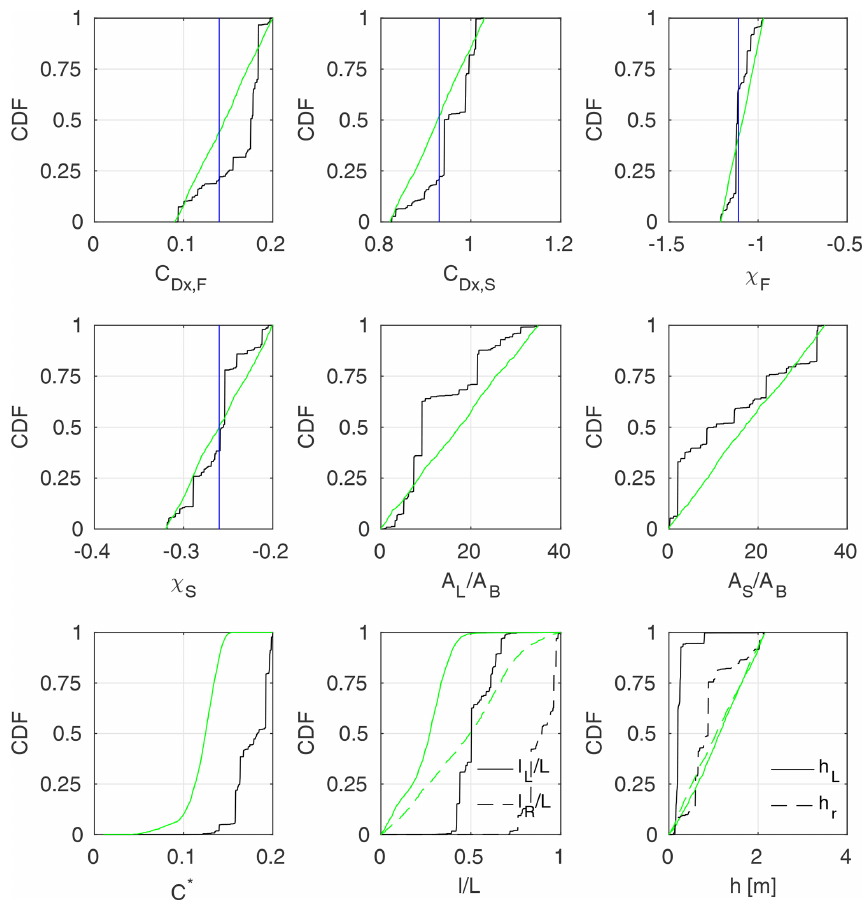
Figure 17. Marginal a posteriori distributions of GTLM model parameters, identified using m = M observation points in the Ritobacken case study; black lines stand for the autumn 2011 set and green for spring 2012; parameter values given by Västilä and Järvelä (2014) for woody vegetation were provided with blue vertical lines.